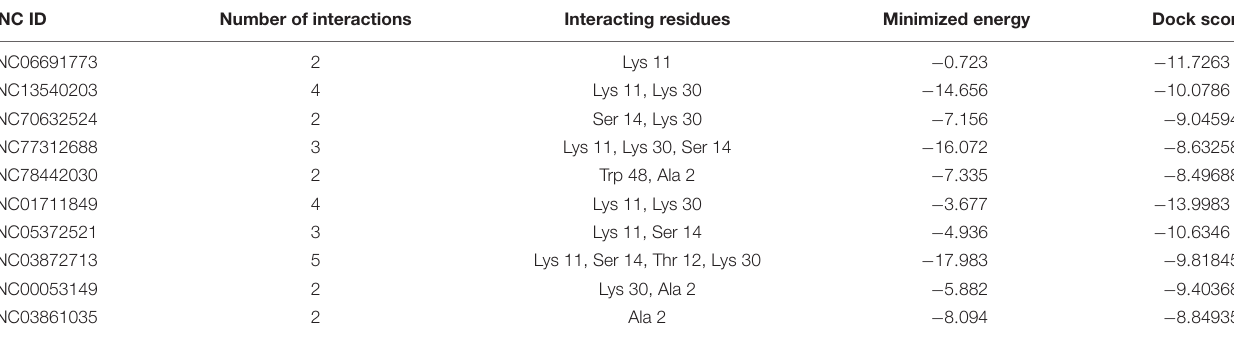
TABLE 13 | 50S ribosomal protein L28 and its interaction profile with docked compounds, their ZINC ID, minimized energy, number of interactions, dock score, and interactive residues. ZINC